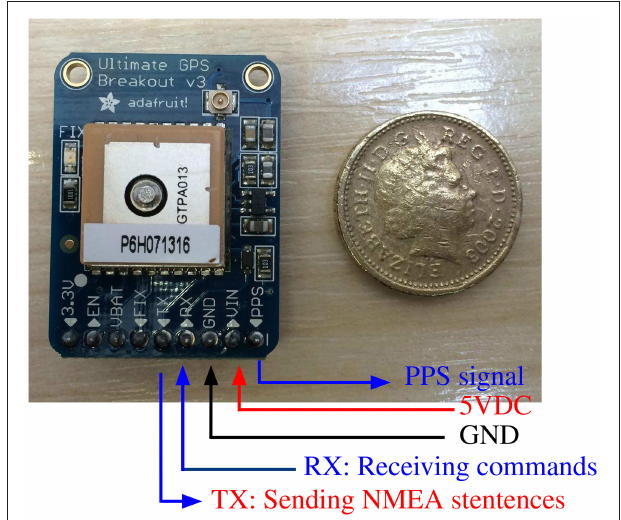
FIGURE 1 | Low-cost GPS module: Adafruit Ultimate GPS